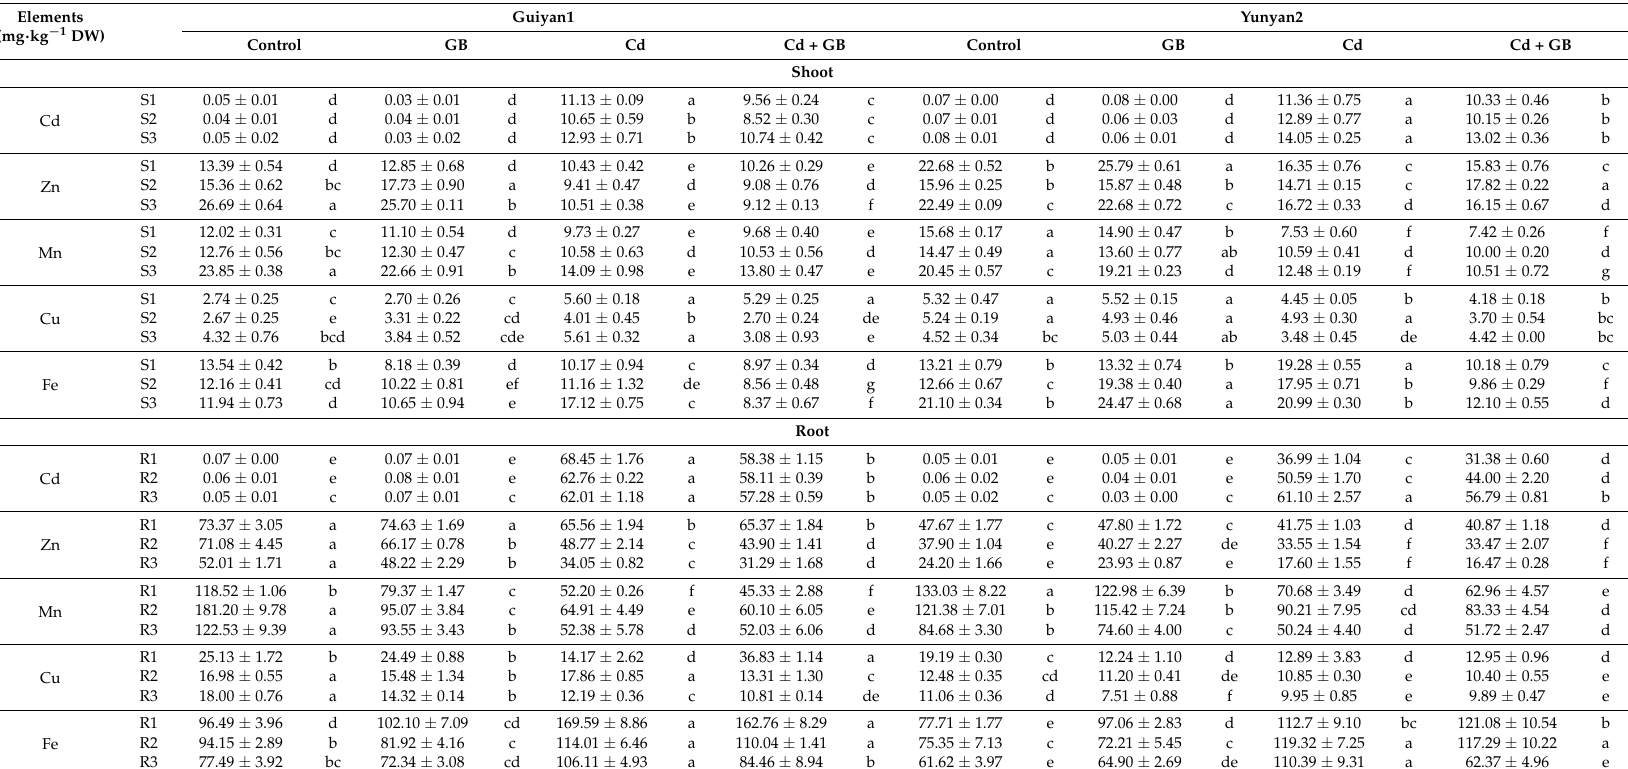
The data were the means of three independent replicates. The different letters in each line indicate the significant differences ( p < 0.05) among the 4 treatments within two cultivars. S1, S2, and S3 correspond to the top part of the shoot (three top leaves with stem), the middle part of the shoot, and the bottom part of the shoot (three bottom leaves with stem), respectively; R1, R2, and R3 correspond to the top part of the root (three cm of root top), the middle part of the root, and the bottom part of the root (three cm of root bottom), respectively. Control, GB, Cd, and Cd + GB correspond to BNS + foliar spray of deionized water, BNS + foliar spray of 500 µ M GB, BNS + foliar spray of deionized water + 5 µ M CdCl 2 , and BNS + foliar spray of 500 µ M GB + 5 µ M CdCl 2 ,